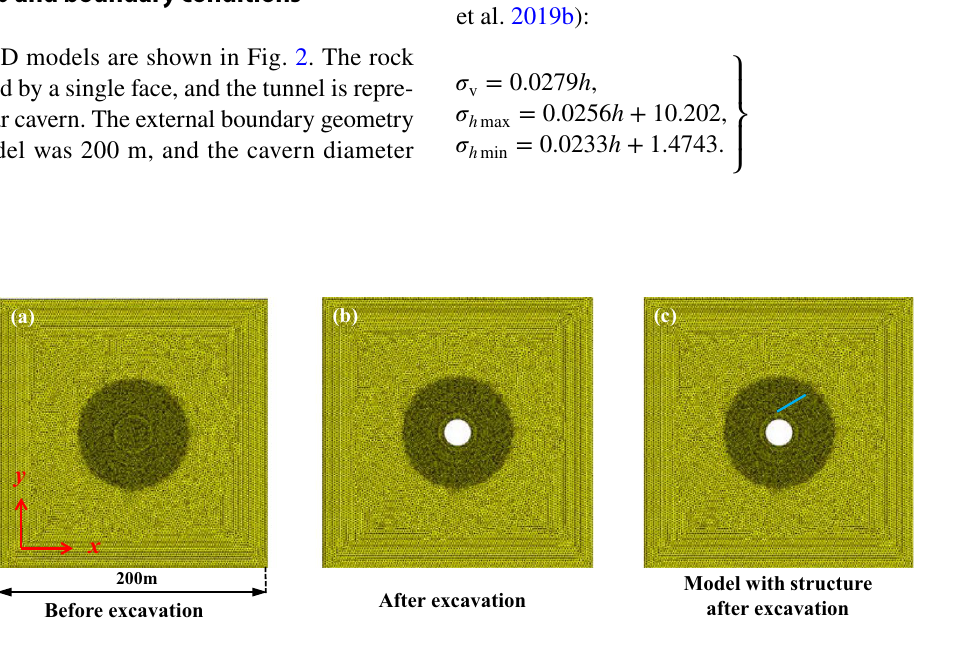
Fig. 2 Geometry size and established model in the current